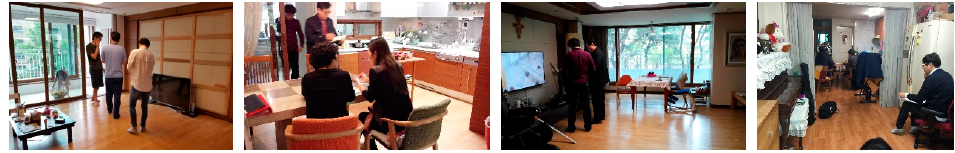
Figure 2. Housing-characteristics data collection through a field survey.